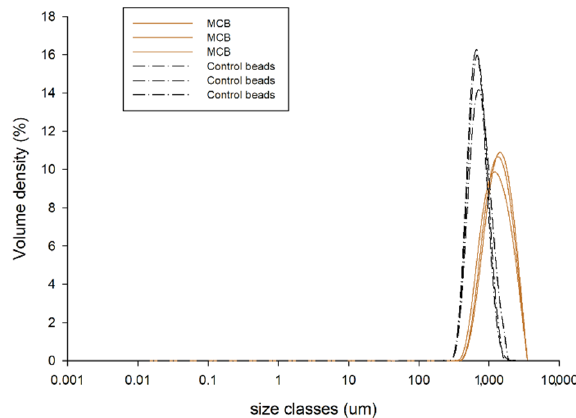
Figure 2. The particle size distribution obtained from the light-diffraction particle size analyzer of control beads and Mesona chinensis beads (MCB) ( n = 3).